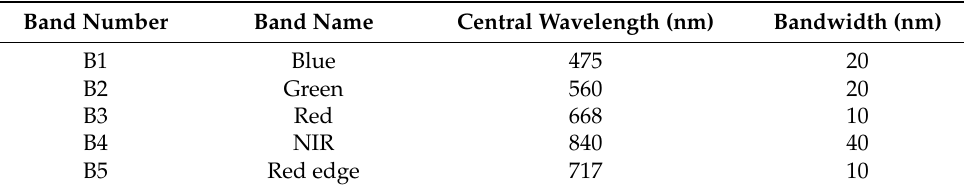
Figure 2. Various pieces of equipment for multispectral data acquisition. ( a ) DJI M600 Pro Hexacopter UAV; ( b ) RedEdge five-band multispectral camera; ( c ) Zenith X3 visible-light camera; ( d ) multispectral camera setup with grey-plate correction. Table 2. Band information for the RedEdge five-band multispectral camera.